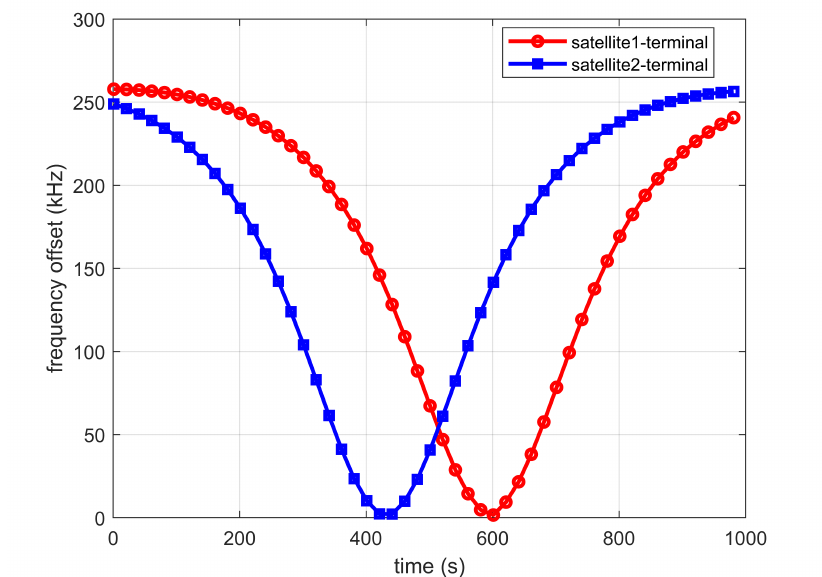
Figure 10. Dynamic characteristics of frequency offset along with time.